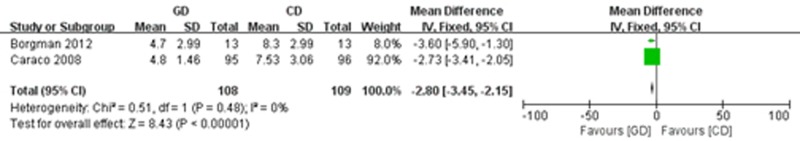
Forest plot of the time to first therapeutic INR.